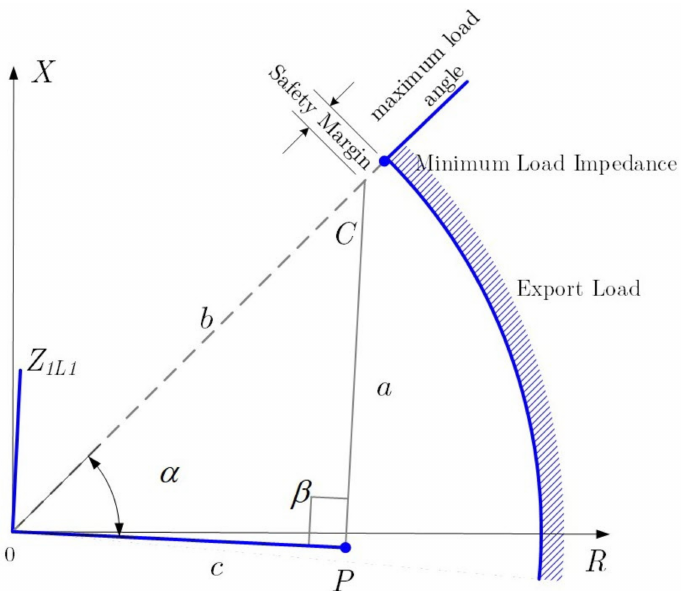
Figure 9. Impedance plane depicting the main elements to calculate R 1 R 7 . Rearrange the equation of R 1 R 7 and multiply by a safety factor; in this paper, the safety factor is selected to be 90 per cent to calculate R 1 R 7